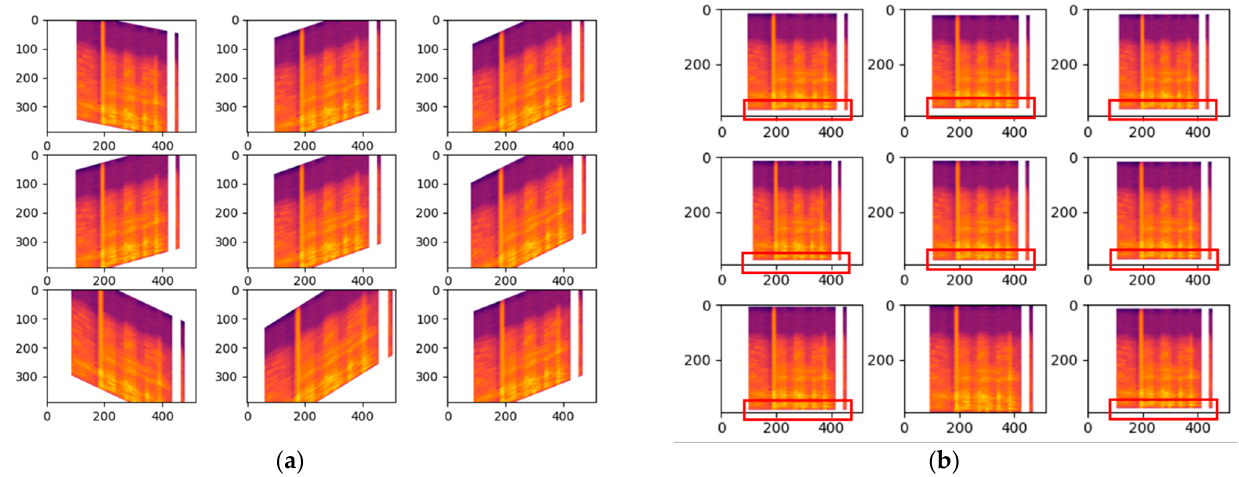
Figure 5. ( a ) Shear range of the Mel-spectrogram of cough wave images; ( b ) changes zoom in–out.